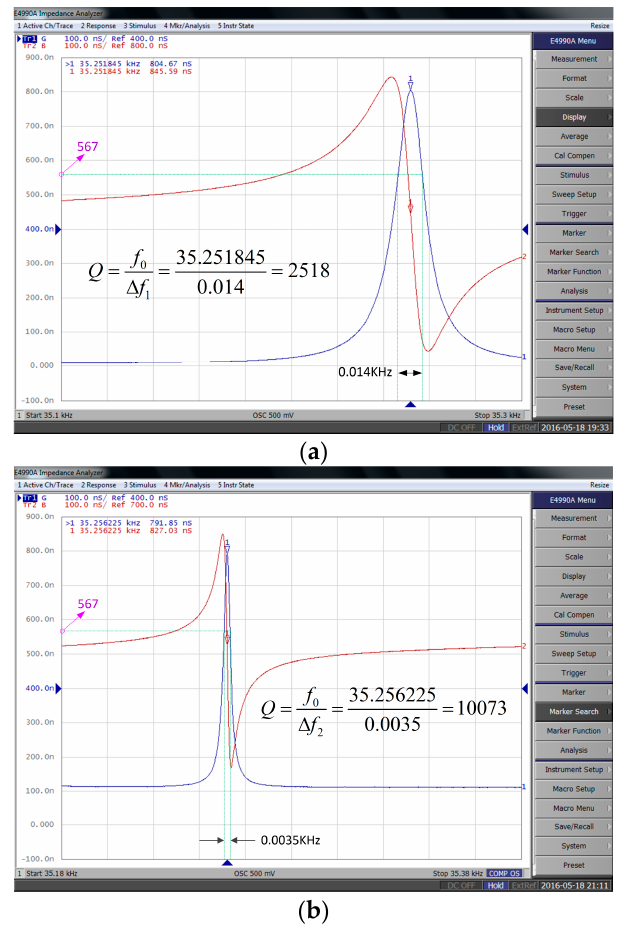
Figure 25. Impedance test results of quartz DETF: ( a ) impedance test results in the air; and ( b ) impedance test results in the low vacuum chamber.